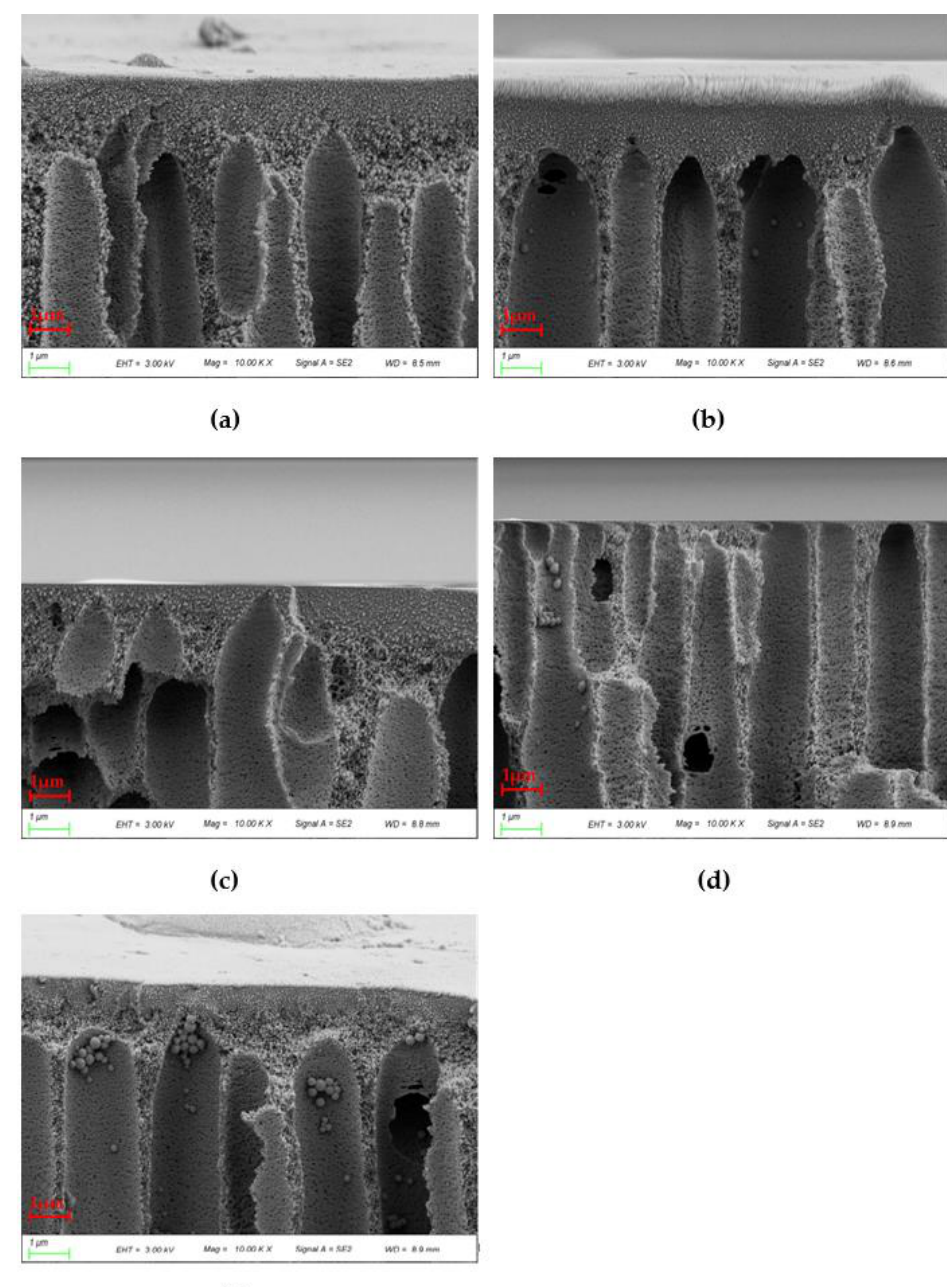
Figure 8. 10 × SEM images of cross sections of various PES/PEI membranes: ( a ) PP-1; ( b ) PP-2; ( c ) PP-3; ( d ) PP-4; ( e ) PP-5.